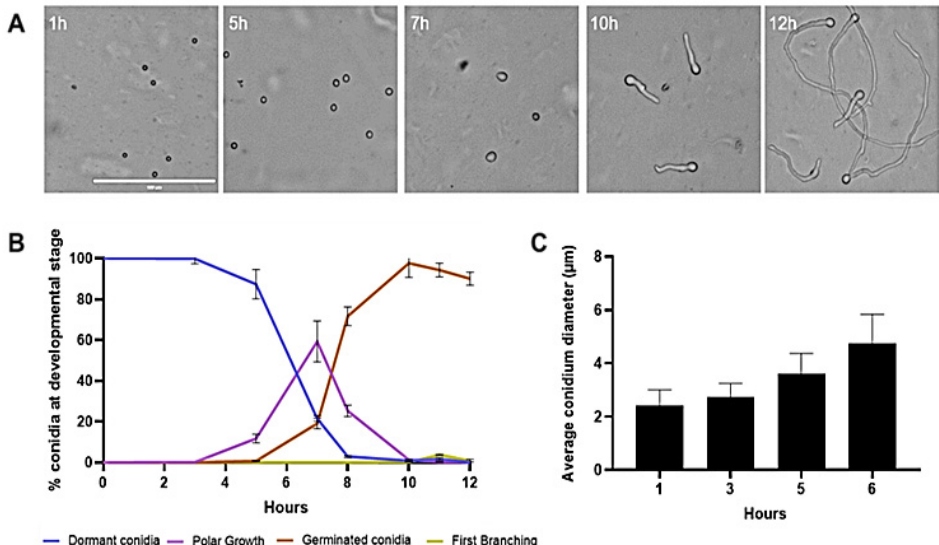
Figure 1. Phenotypic characterization of conidia germinating on PDA. ( A ) Conidia germinated in PDA were imaged at 1, 5, 7, 10, and 12 h; scale bar: 100 µ m for all images). ( B ) The degree of synchronous progression of germination was monitored and cells were assigned as either dormant conidia, polar growth, doubling of long axis, or first hyphal branching. ( C ) Average diameters of conidia were assessed during the early stages of germination; whiskers indicate the standard deviation of the mean for the three biological